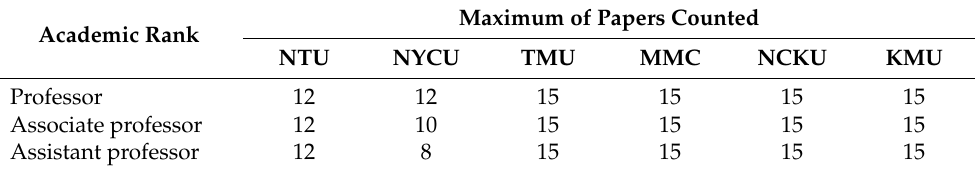
Table 5. Maximum of papers counted for the promotion of different academic ranks in 13 medical schools in